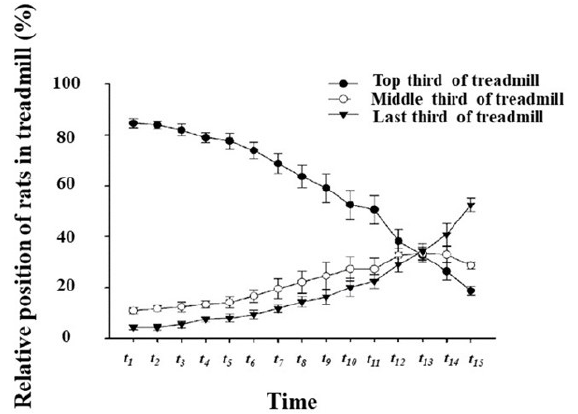
Figure 5 - Percentage of sound stimulation time of total time by time